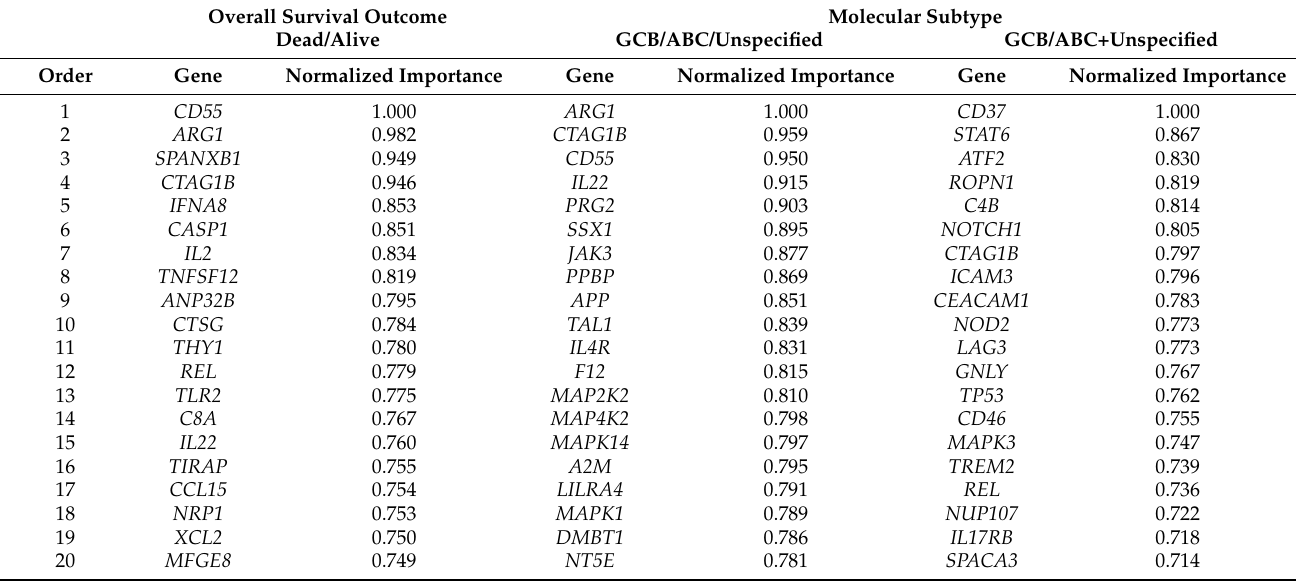
Table 2. Top 20 genes identified by the multilayer perceptron analysis.